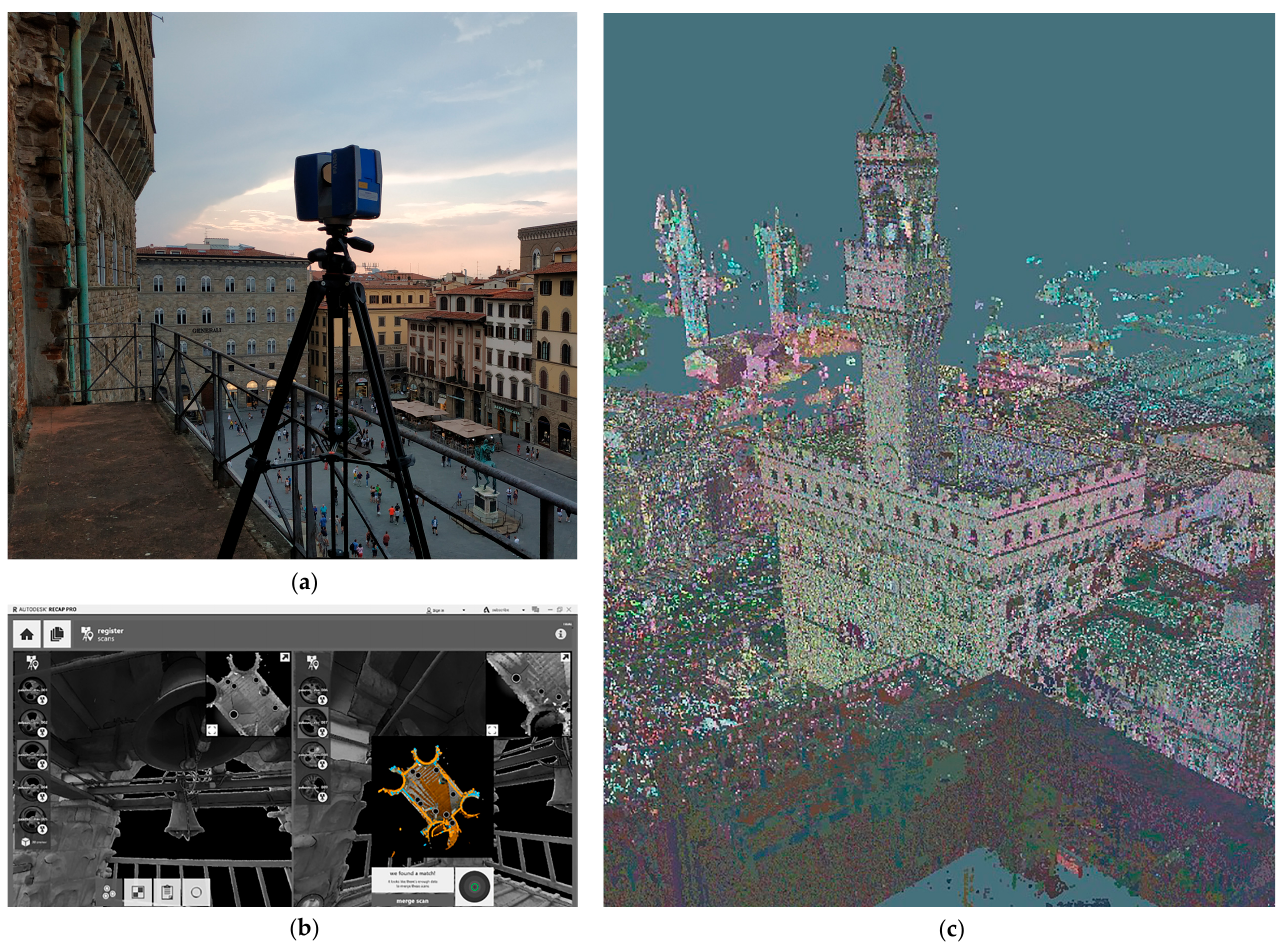
Figure 7. The point cloud from LST survey; ( a ) in-situ acquisitions; ( b ) internal point cloud reconstruction; ( c ) global point cloud of Palazzo Vecchio.